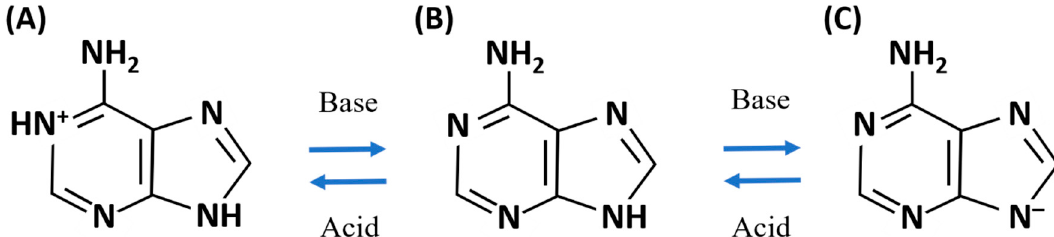
Figure 2. Examples of molecular structures of ( B ) neutral adenine, ( A ) positively charged adenine in alkaline, and ( C ) negatively charged adenine in acid.